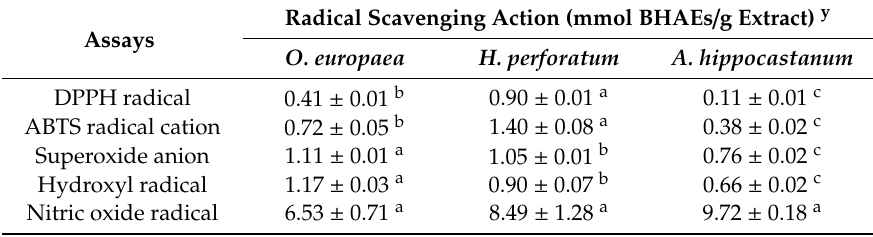
x Di ff erent subscripts in the same row indicate significant di ff erence ( p < 0.05, abc); y BHAEs, butylated hydroxyanisole